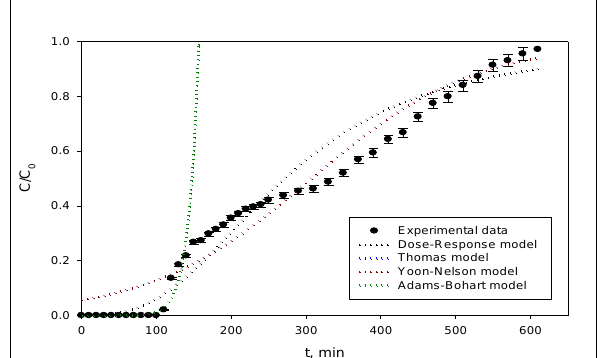
Figure 5: Non-linear plot of Thomas, Yoon-Nelson, Adams-Bohart and Dose-response models for the adsorption of phenol using 47.5 g of